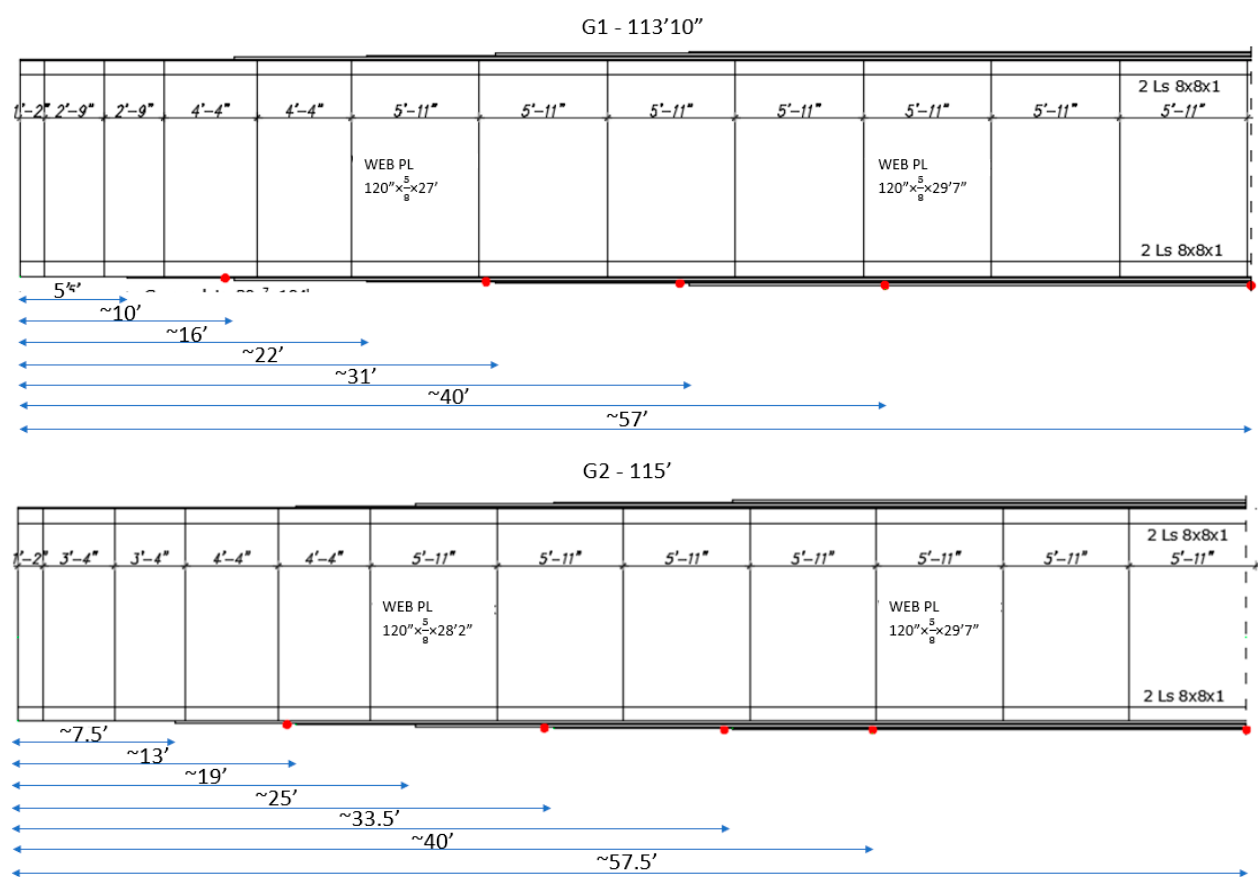
Figure 4. Investigated deck plate girder (DPG) bridge dimensions and strain gauge locations (1 ft = 0.305 m).